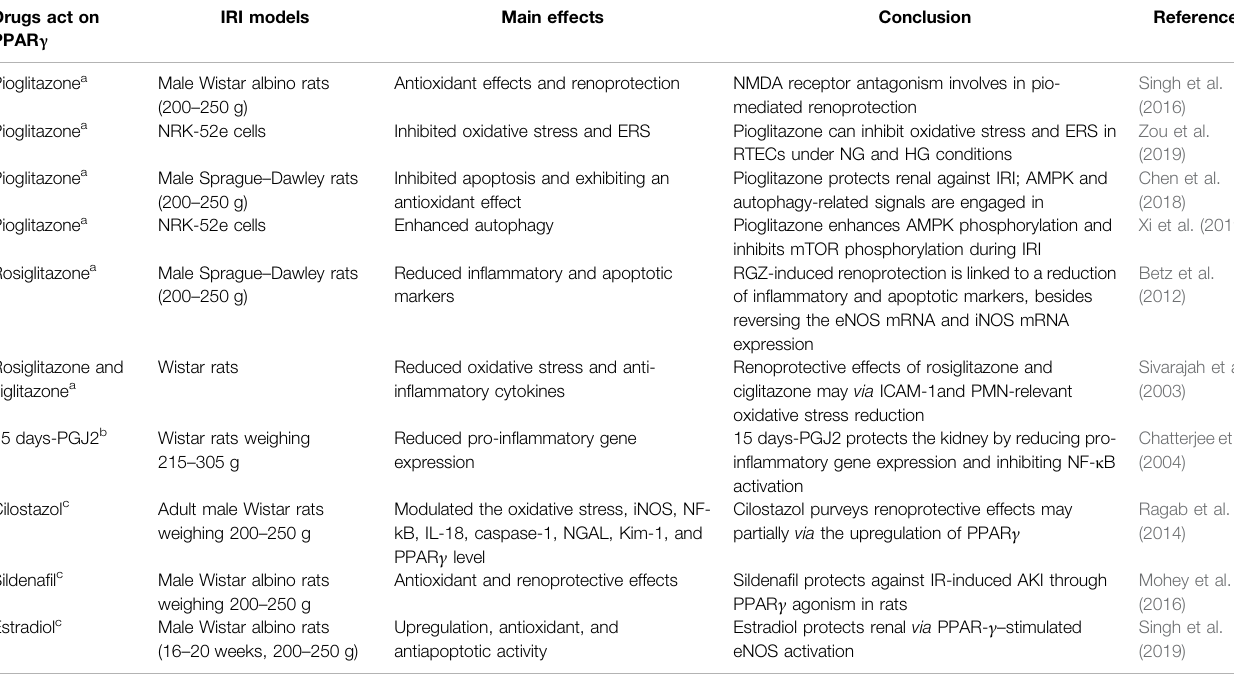
TABLE 1 | Summarization of the effects of drugs acting on PPAR γ in renal